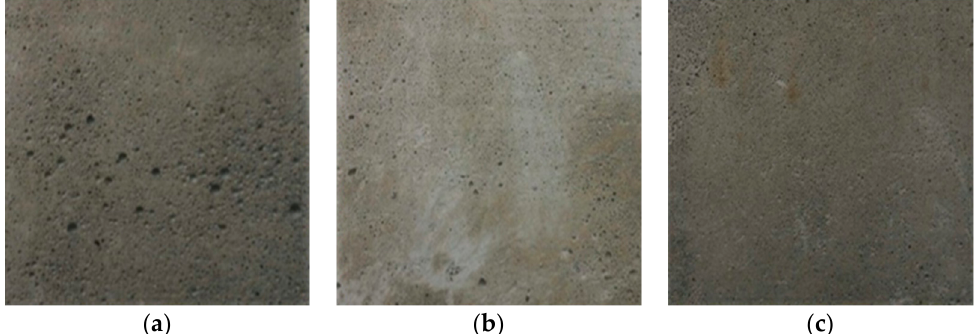
Figure 1. Optical images of non-autoclaved foam concrete specimens [21]: ( a ) Type 1 ; ( b ) Type 2 ; ( c ) Type 3